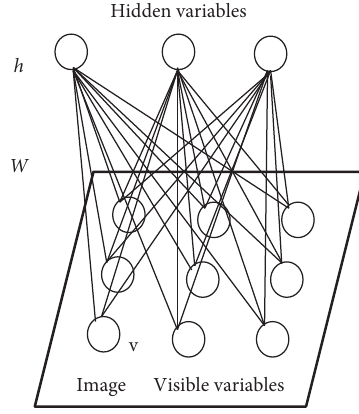
Figure 6: The basic structure of